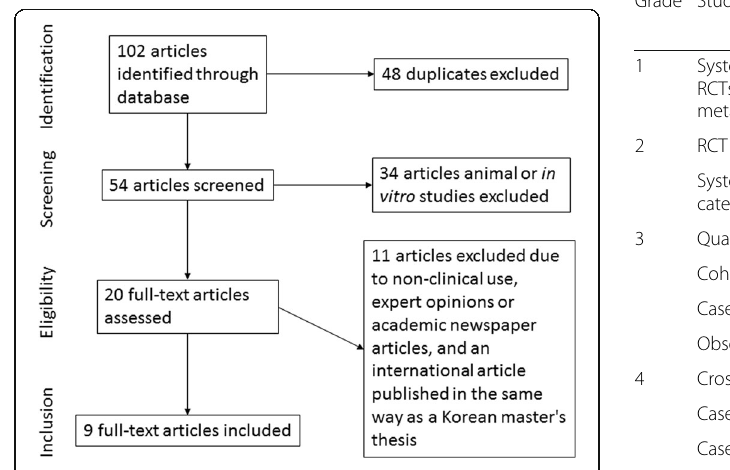
Fig. 1 The flow chart of the search strategy of the Korean literature